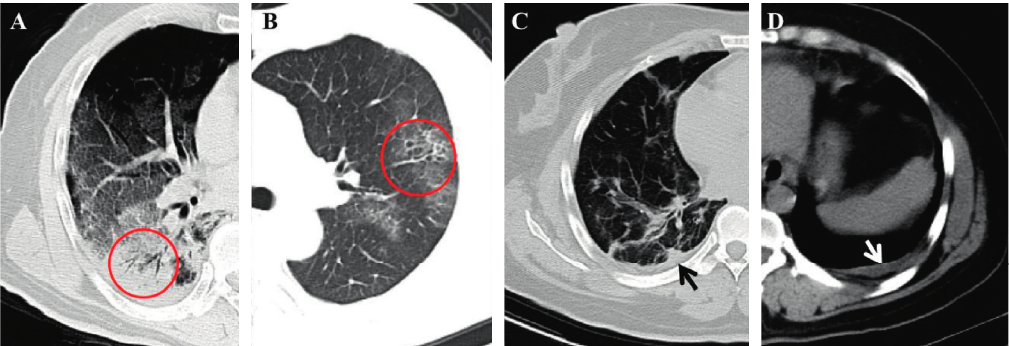
Figure 2: (a) A 60-year-old male COVID-19 patient with initial symptoms of dry cough and fever for 3 days. CT scan shows air bronchogram in the right lower lobe (red circle) (10 days after the onset of initial symptoms). (b) A 46-year-old male COVID-19 patient with fever. CTscan demonstrates bronchiolectasis in the left upper lobe (red circle) (14 days after the onset of initial symptoms), and the bronchial wall thickening is also observed. (c, d) A 40-year-old female confirmed patient with nasal discharge and generalized aches for 11 days. The CT shows the pleural thickening (black arrow) and a small amount of pleural effusion (white arrow) (12 days after the onset of initial symptoms). Table 3: The less frequent CT findings acquired from the published literature.